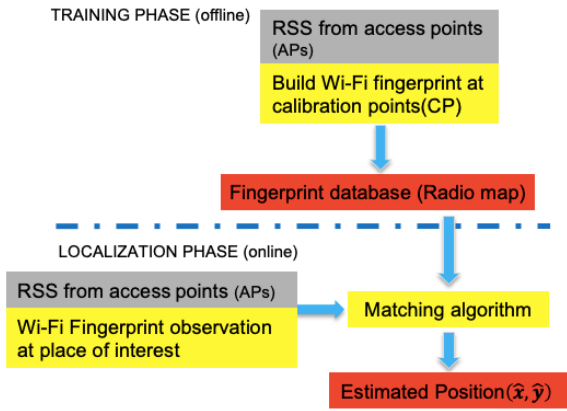
Figure 3. CNN architecture with the NetVLAD